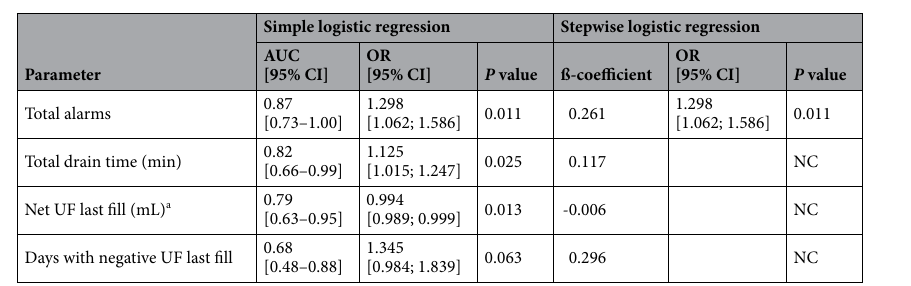
Table 3. Summary of simple and stepwise logistic regression of the parameters for predicting catheter dislocation. a Corresponding to daytime dwell. AUC, area under the curve; CI, confidence interval; NC, no candidate; OR, odds ratio; SE, standard